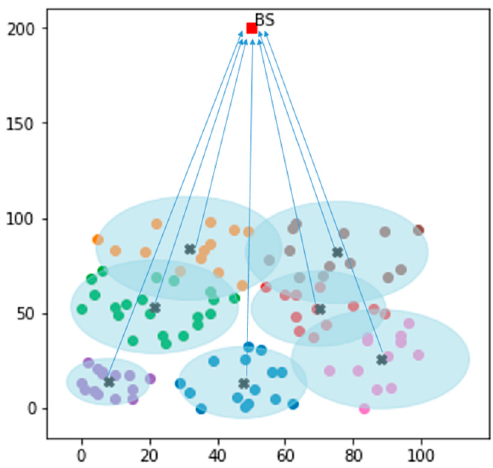
Figure 15. Depiction of network clusters along with respective centroids (each cluster communicates directly with the BS).